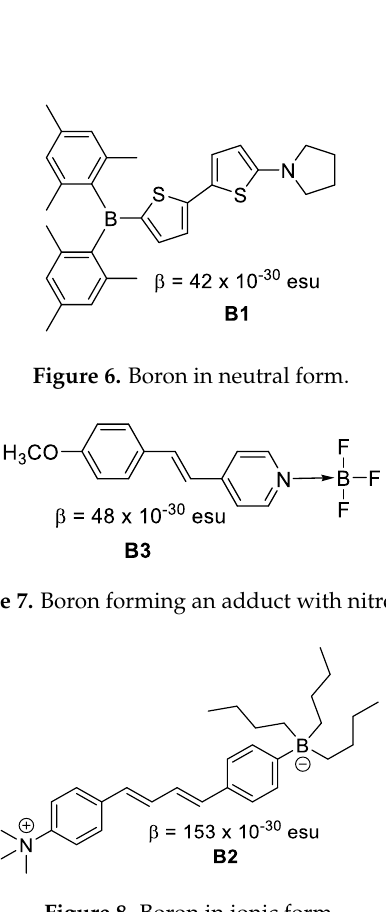
Figure 7. Boron in ionic form. Figure 8. Boron forming an adduct with nitrogen. Figure 8. Boron in ionic form. Figure 8. Boron forming an adduct with nitrogen.